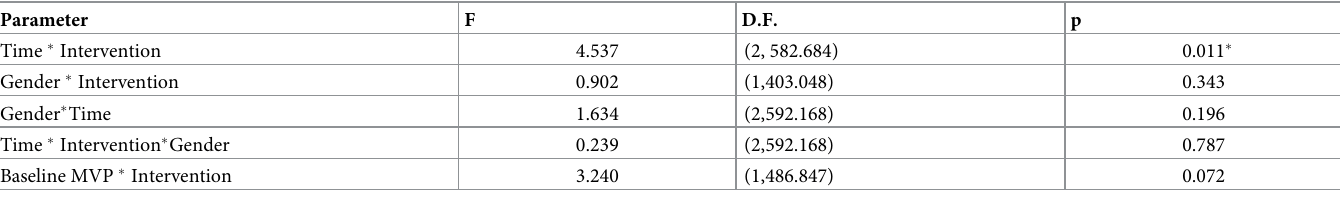
Table 4. Type III analysis of interaction effects.